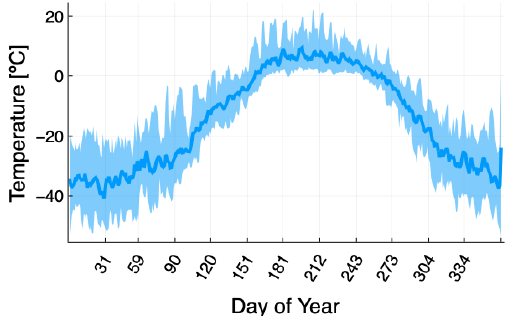
Figure B1. Daily temperature extracted from ERA-Interim reanalysis data (Dee et al., 2011) and averaged over all years from 1951 to 1980 (i.e. the same period from which the average daily discharge in Fig. 8 is obtained). The lighter-shaded ribbon around the average line shows the range of daily temperatures during the same period.